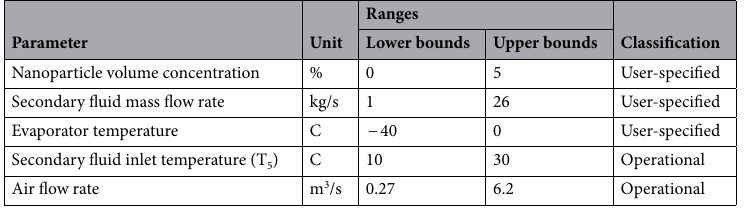
Table 4. Parameters investigated in the HVAC